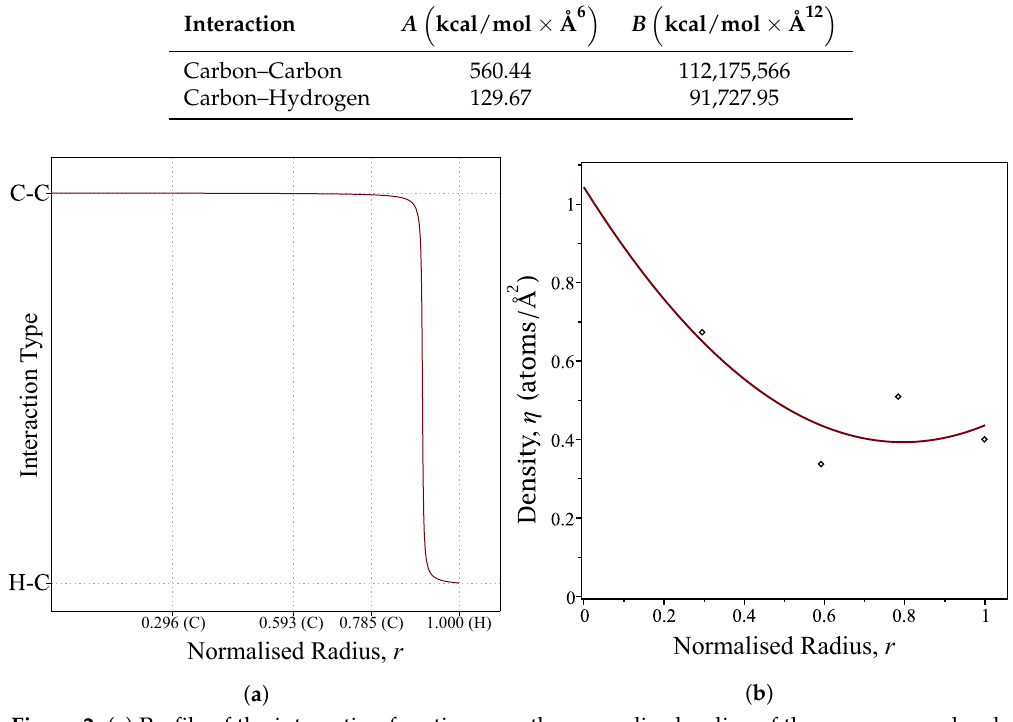
Table 1. Attractive and repulsive constants for carbon–carbon and carbon–hydrogen interactions.